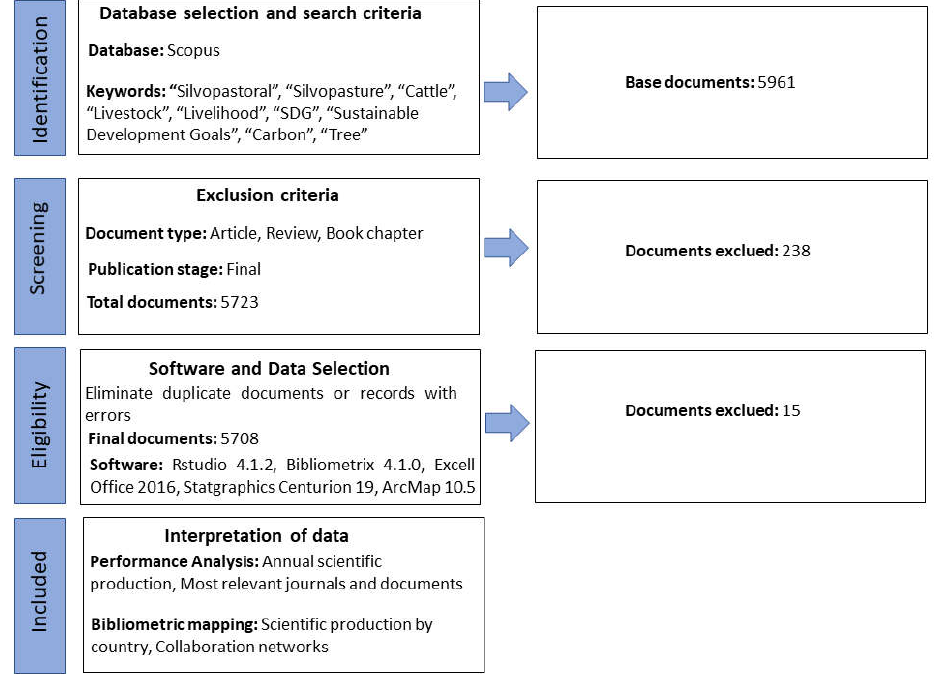
Figure 1. Diagram based on the PRISMA (Preferred Reporting Items for Systematic Reviews and Meta-Analyses) methodology, depicting the four phases of bibliometric research methodology. Meta-Analyses) methodology, depicting the four phases of bibliometric research